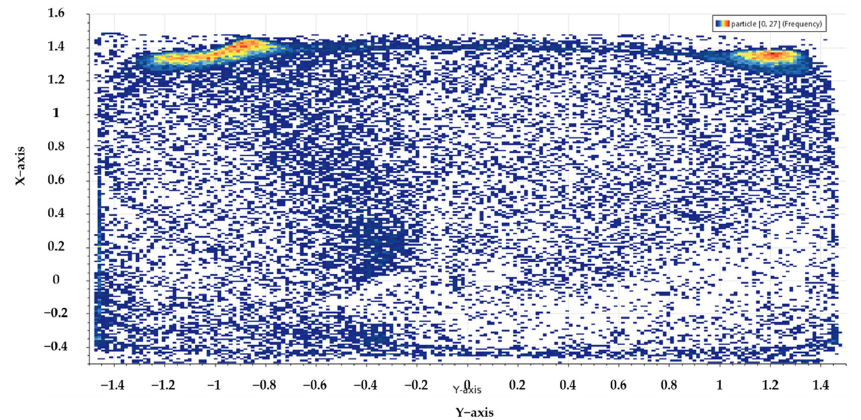
Figure 14. Location and velocity distribution of particles in a1~a10. Figure 15. Thermal map of particles distribution in Figure 15. Thermal map of particles distribution in a10.